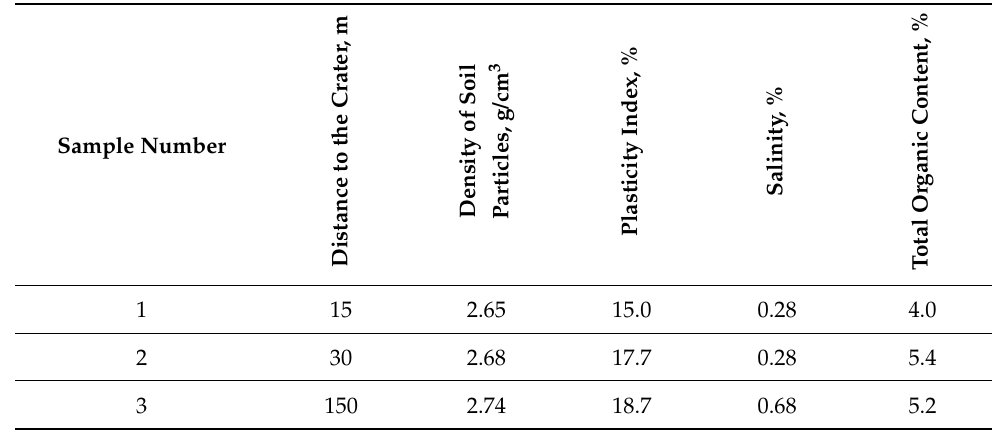
Table 2. Selected characteristics of soil ejected during the crater